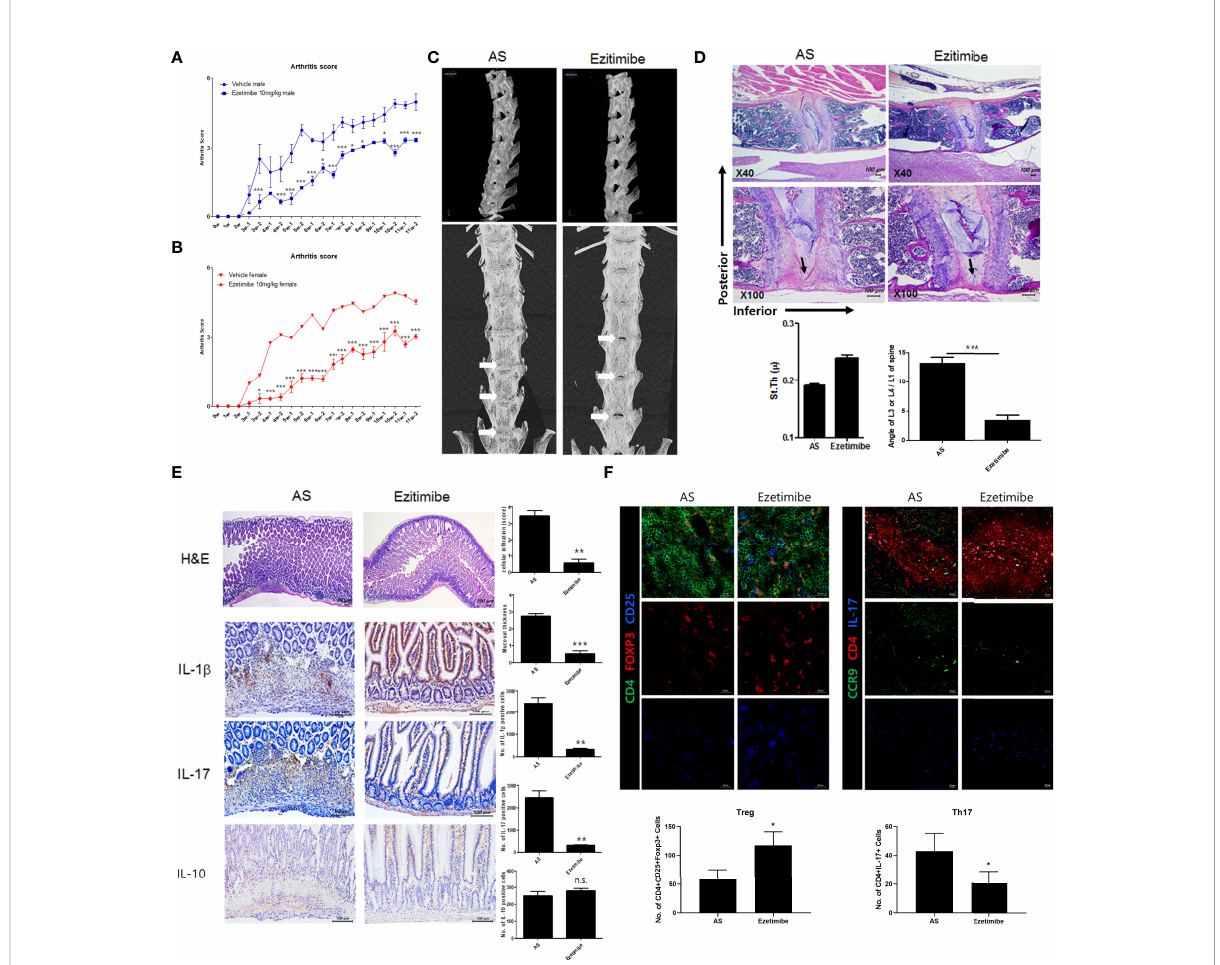
FIGURE 1 Ezetimibe ameliorated AS symptoms in mice. (A, B) Arthritis score and incidence in ezetimibe-treated and untreated AS mice. (C) Computed tomography showed that ezetimibe has a therapeutic effect on the spine in AS mice. Osteogenesis was observed in the lumbar disc region of AS mice (white arrows). (D) Immunohistochemistry images showed that the anterior lumbar spine of untreated AS mice exhibited stenosis and osteogenesis (black arrows). Scale bars = 100 µm. (E) Immunohistochemistry of small intestine tissue showed that ezetimibe decreased mucosal wall thickness, cell in fi ltration, and expression levels of proin fl ammatory cytokines (e.g., IL-1 b and IL-17). Scale bars = 100 µm. (F) Immuno fl uorescence showed that ezetimibe reduced Th17 cell number and increased Treg cell number. Scale bars = 20 µm. Values are means ± standard errors of the mean (SEMs) of three independent experiments. *p < 0.05, **p < 0.01, ***p <